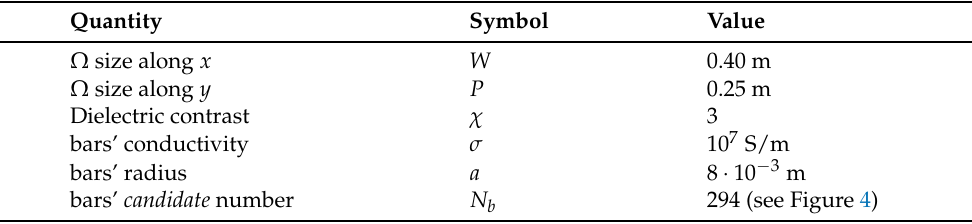
Table 2. Bar and dielectric